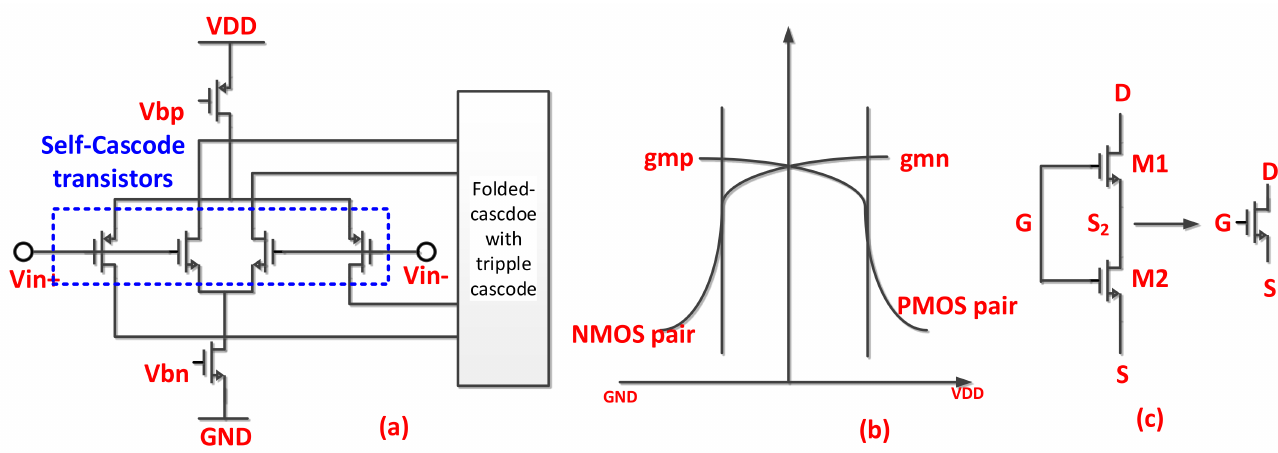
Figure 1. ( a ) The circuit implementation of the overall proposed driver amplifier and ( b ) the biasing circuits.